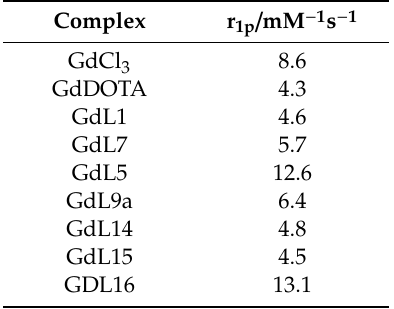
Table 3. Relaxivity values for Gadolinium